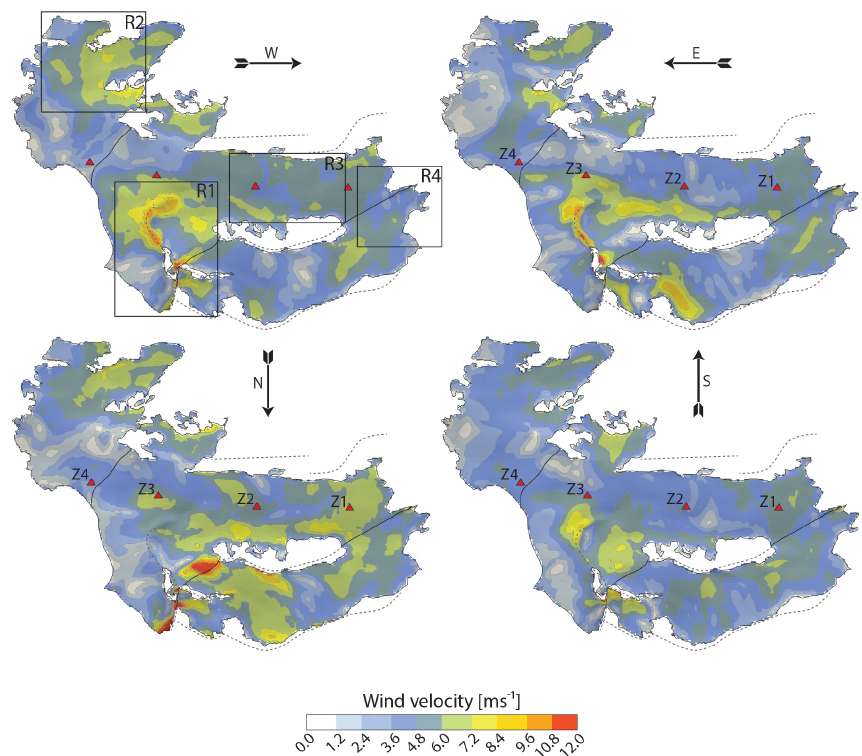
Figure 3. Mean velocity of the surface wind fields (2m) for each of the four case experiment. The four boxes R1–4 and the sites Z1–4 define regions and locations on the glacier which are used for discussion in the results section. The grey dashed lines represent sharp ridges in the study area.